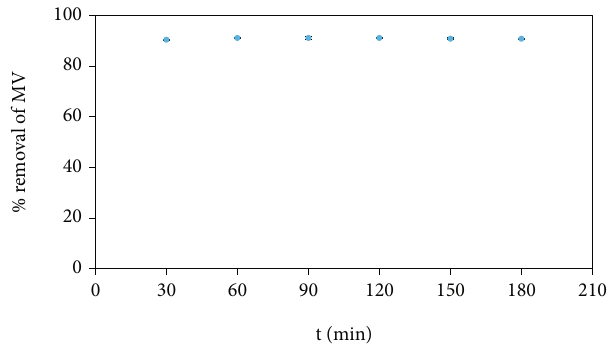
Figure 1: The e ff ect of contact time on the removal of MV via NaOH-KR ( massof adsorbent = 0 : 020 g; volume of MV solution = 10 : 0 mL; concentration of MV = 100 mgL -1